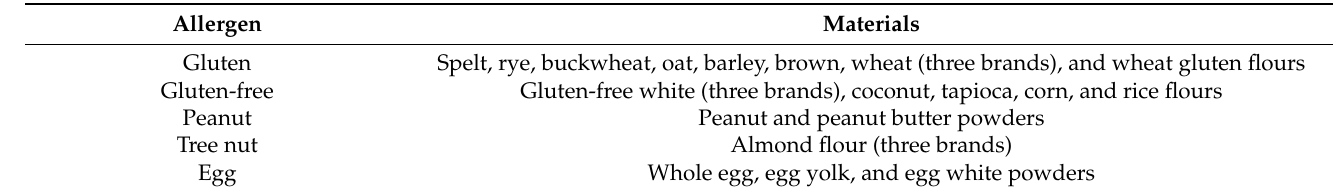
Table 1. Food powder materials measured using near-infrared spectroscopy. In total, 19 food powder materials were measured.